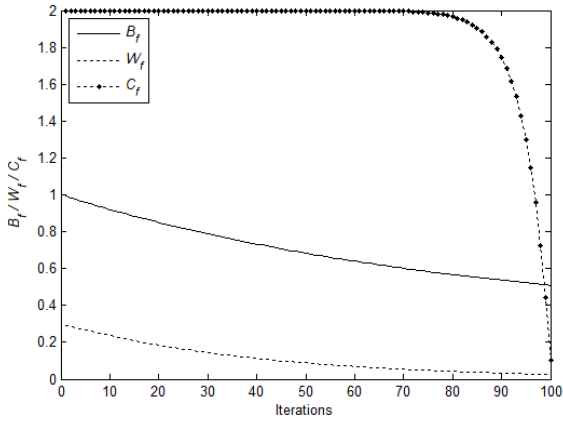
Figure 5. Variations of B f , W f , and C f over iterations.